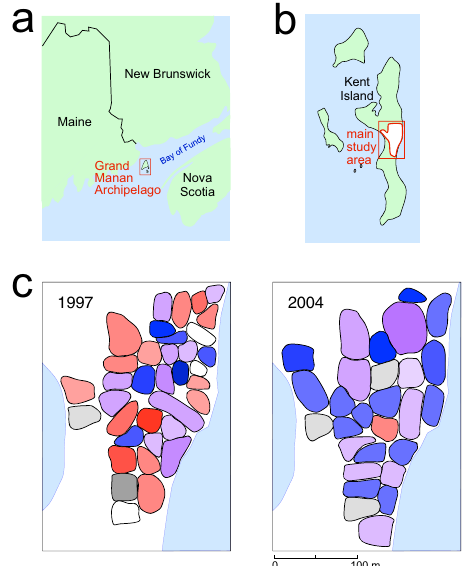
Fig. 1 Study site location and distribution of click train and high note cluster singers ’ territories. a The Grand Manan Archipelago lies in the southwest Bay of Fundy; Kent Island is the southeasternmost island in the archipelago. b Kent Island and the location of the main study site, which includes the largest contiguous set of territories that were followed continuously (images in a and b modi fi ed from Google Maps). c Representative examples of territories within the main area of the study site. In 1997 click trains and high note clusters were equally represented, and in 2004 click trains were sung by the majority of males. Blue = territories of males singing click trains, red = males singing high note clusters, and purple = males singing both features. Territories of older birds are shown with darker shades. Territories of males whose songs were not recorded are shown in white and those with songs that included neither introductory feature are shown in gray. Depending upon conditions, songs can be heard from 50 to 150m from the n = 10, p < 0.0001). At the same time, variation in the number of clicks in a train also increased as more males sang click trains (Fig. 3c; R 2 = 0.62, n = 17, p < 0.001). These increases in the range, average, and population-wide variation in the number of clicks sung in a male ’ s train began more than 15 years (and